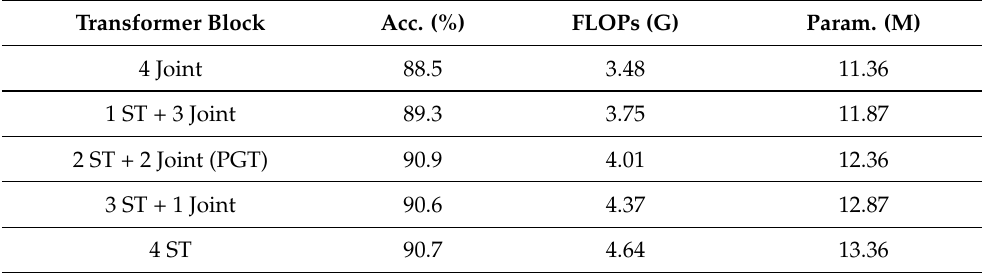
Table 2. The ablation study on the NTU-RGBD 60 CS benchmark, denoting the effect of ST and joint transformer